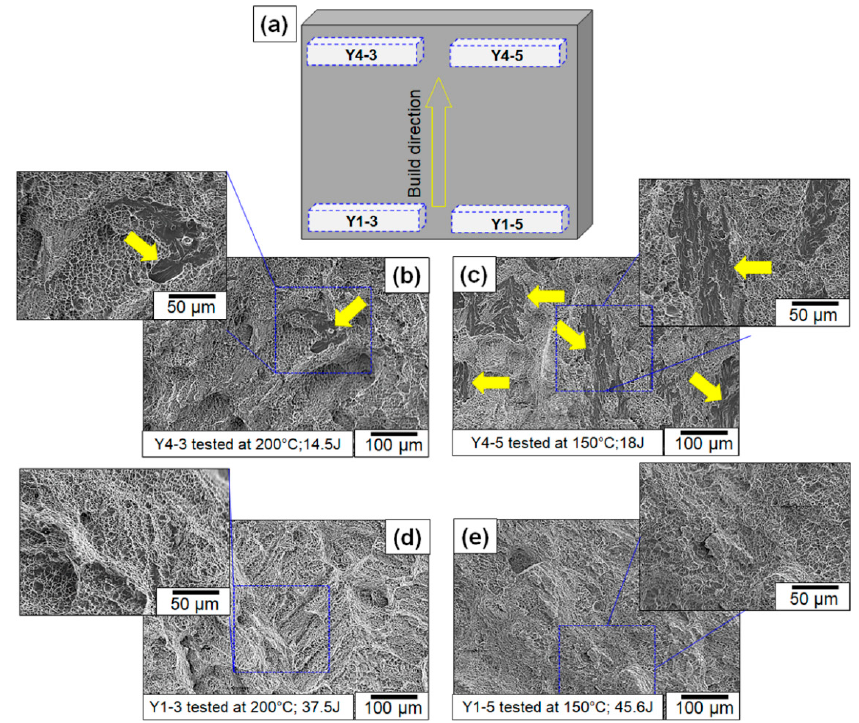
Figure 4. ( a ) Pictorial diagram showing the position of Charpy samples on the fabricated wall. Fractographs of Charpy samples sectioned from ( b , c ) top and ( d , e ) bottom of the build. Yellow arrows are showing brittle failure modes in the above figures.